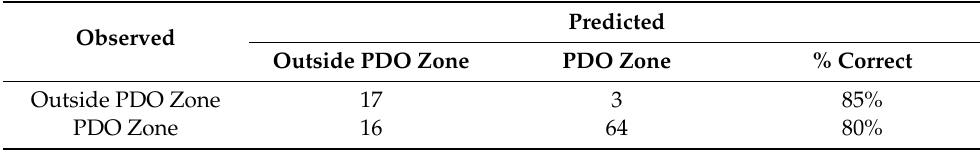
Table 4. Binomial logistic regression: classification analysis. Predicted Observed Outside PDO Zone PDO Zone %